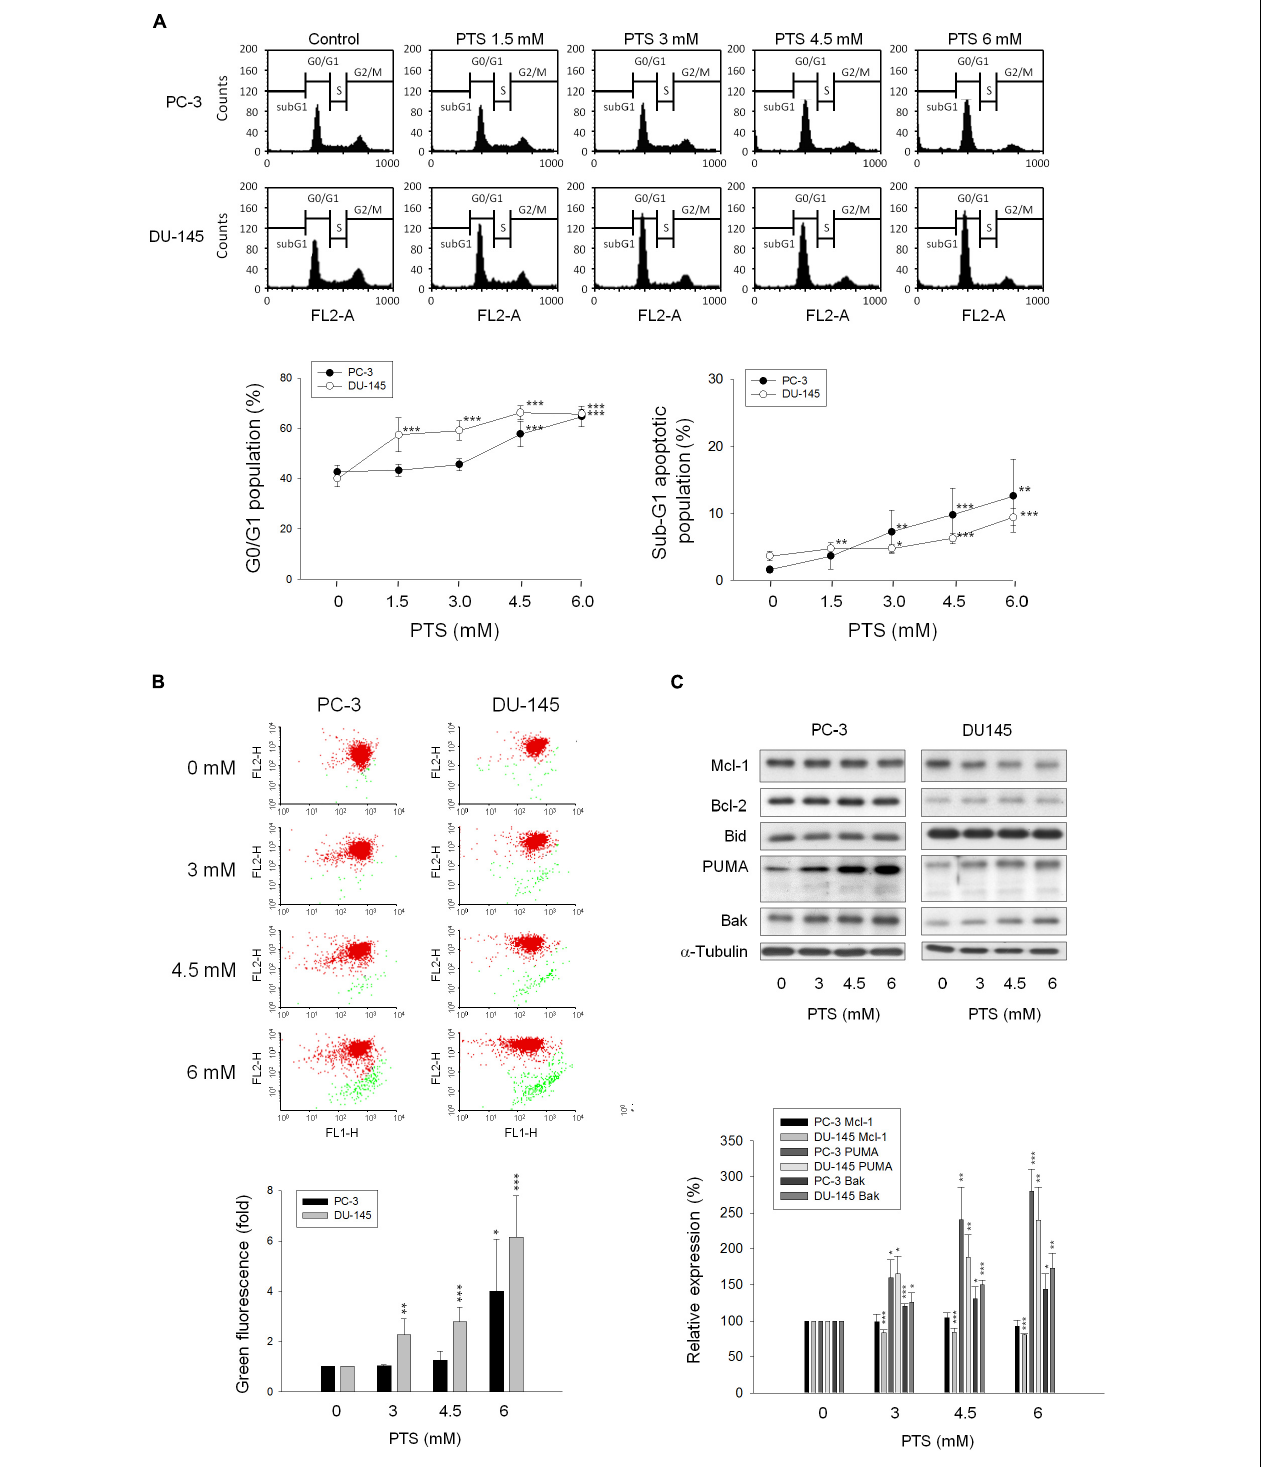
FIGURE 2 | Effect of PTS on cell cycle arrest and mitochondrial dysfunction. PC-3 and DU-145 cells were incubated in the absence or presence of PTS for 24 (A,C) and 48 h (B) . The cells were harvested for propidium iodide staining to analyze the distribution of cell populations in cell cycle phases (A) , or for JC-1 staining to detect mitochondrial membrane potential using FACScan flow cytometric analysis (B) . The green fluorescence was shown for the quantification of mitochondrial membrane potential (B) . (C) The cells were harvested and lysed for the detection of protein expressions of several Bcl-2 family members by Western blot analysis. Data are expressed as mean ± SD of three to five determinations. ∗ P < 0.05, ∗∗ P < 0.01 and ∗∗∗ P < 0.001 compared with the control.